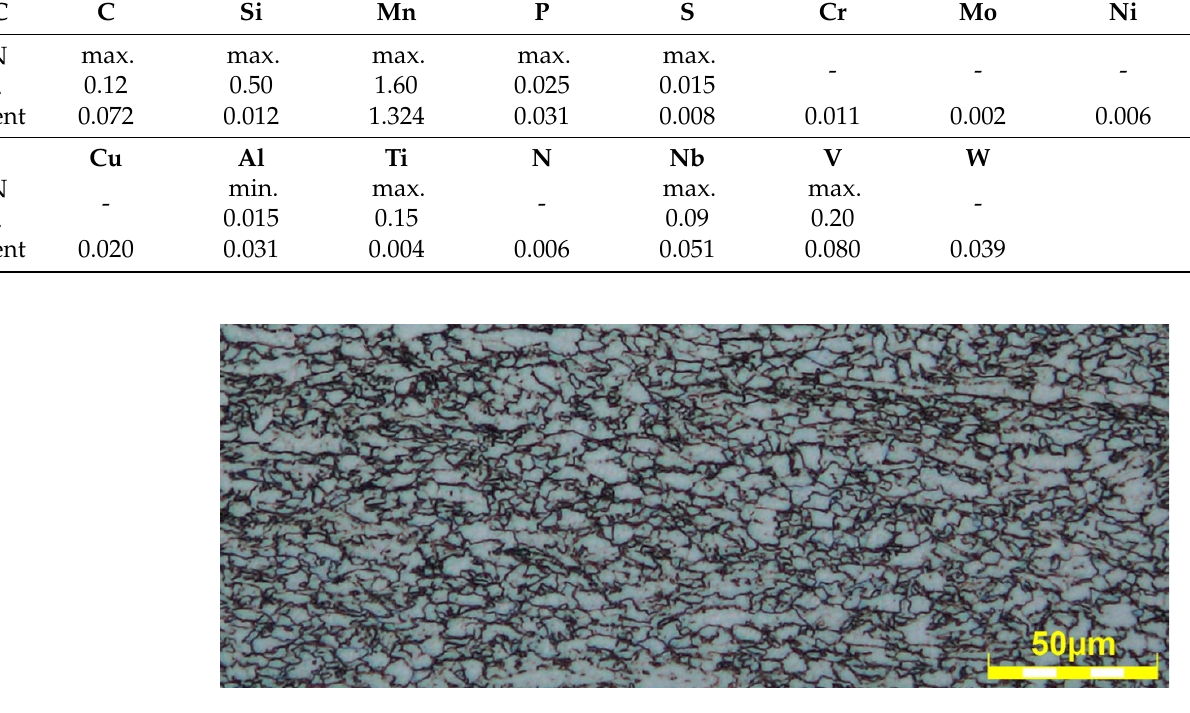
Table 1. Chemical composition (wt. %) of steel S460MC.